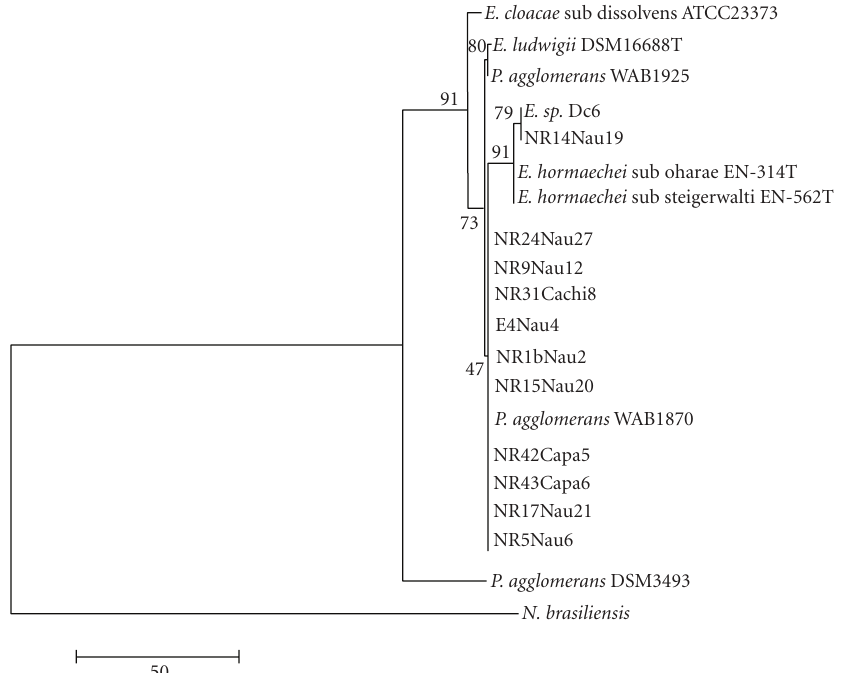
Figure 1: Phylogenetic tree based on 1367 bp without gaps from 16S rRNA gene. Nocardia brasiliensis was used as the out-group of phylo- genetic